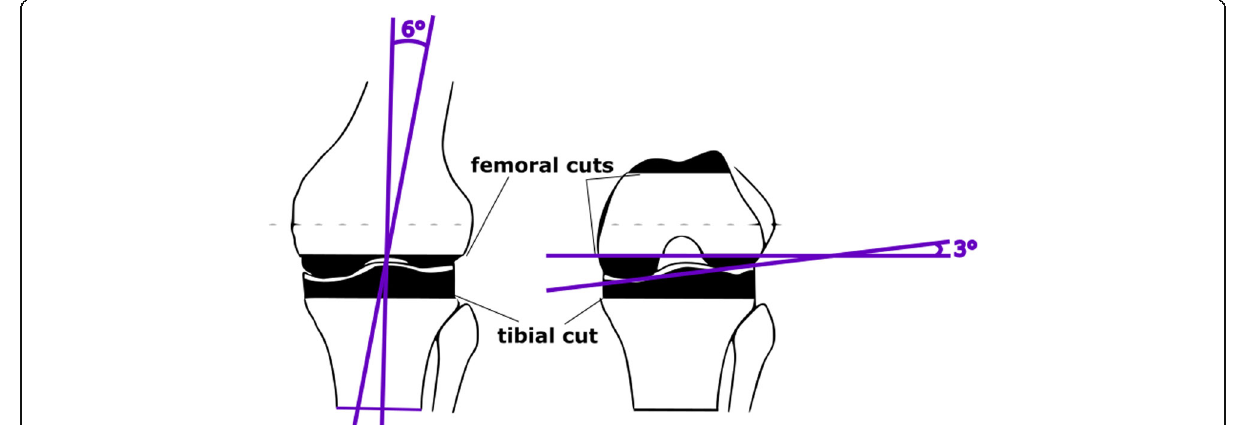
Fig. 7 Illustration of the measured resection of 6 degrees of valgus and 3 degrees of external rotation